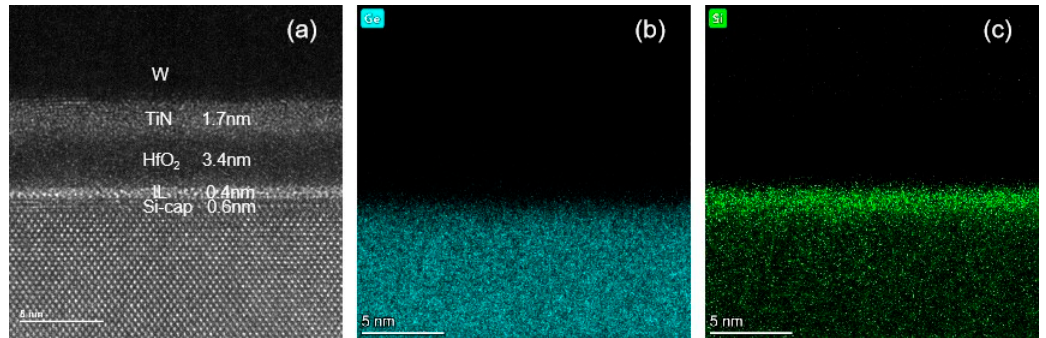
Figure 5. ( a ) HRTEM, ( b ) Ge, and ( c ) Si element EDX mapping of the W/TiN/HfO 2 /IL/Si ‐ cap/Si 0.7 Ge 0.3 MOS capacitor with 1 nm Si ‐ cap.